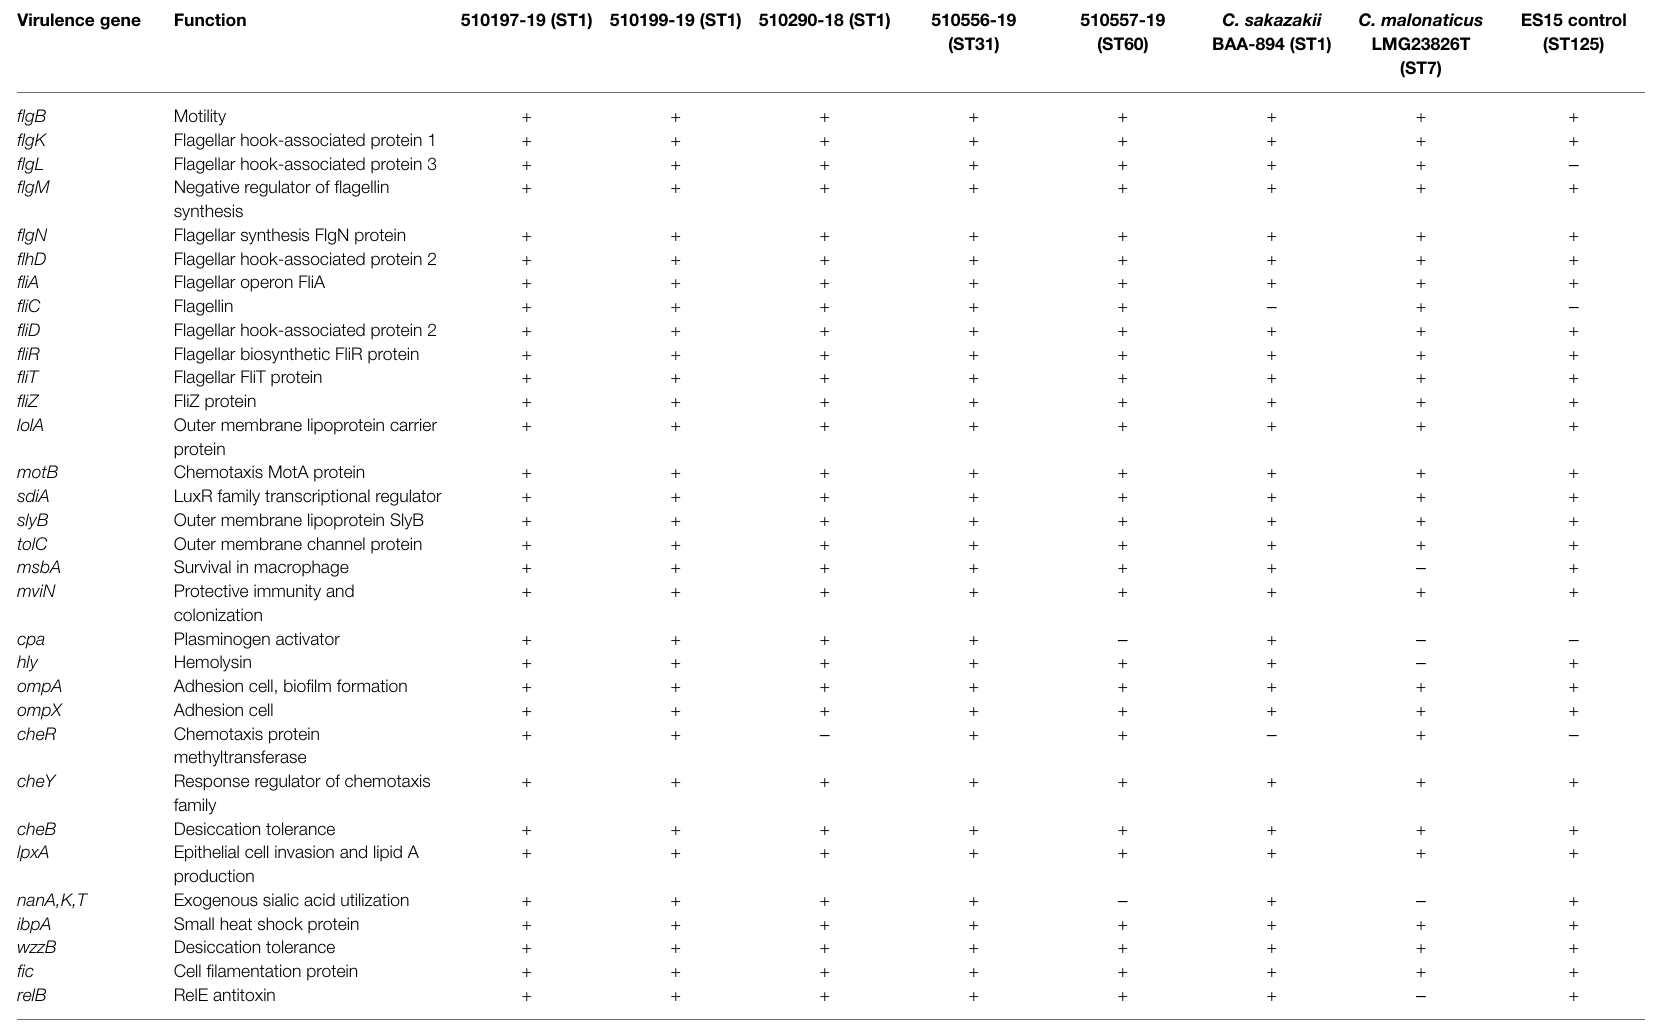
TABLE 5 | Putative virulence and distribution of other genes in seven strains of Cronobacter spp. by WGS. Virulence gene Function